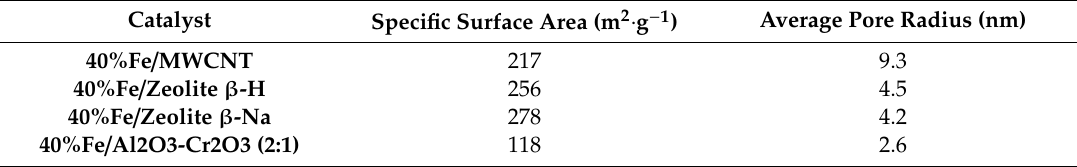
Table 3. The results of the specific surface area and average pore radius of iron